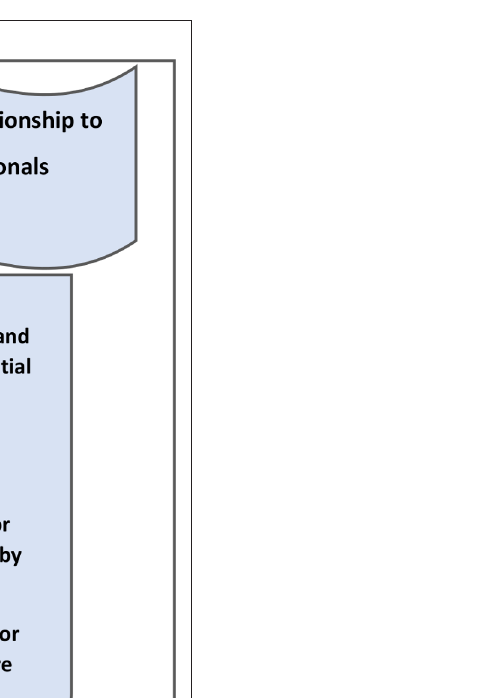
Mannheimer S et al . BJGP Open 2022; DOI: 10.3399/BJGPO.2021.0181